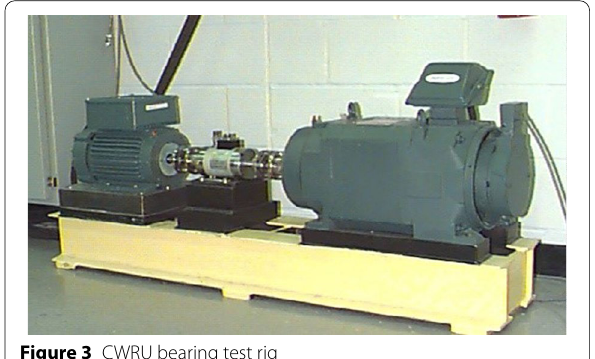
Figure 4 Bearing test rig